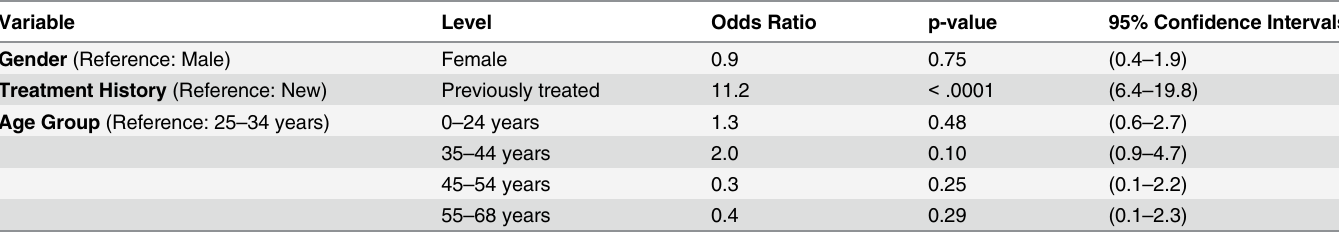
Table 4. Risk factors for MDR-TB